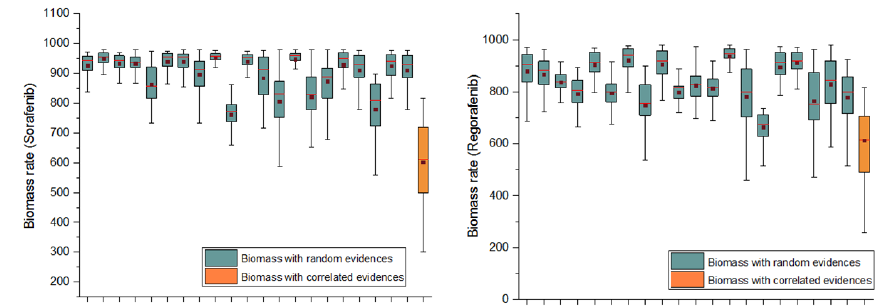
Figure 6. Comparison between predicted HCC tumor cell biomass rates with a random evidence set and those with approved drugs targets and their correlated genes.